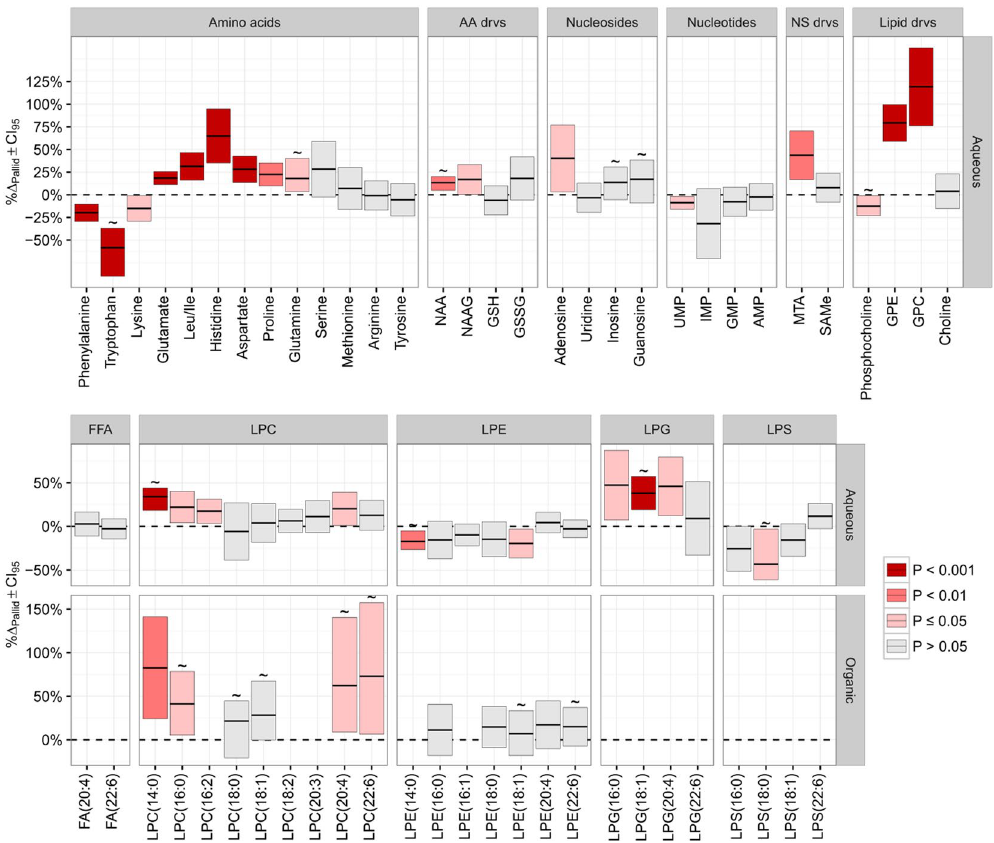
Figure 3. Percentage change for metabolite levels in hippocampi of pallid mice (% Δ Pallid ± 95% confidence intervals) with respect to wild-type (WT) animals. The following formula was used: % Δ Pallid = 100% * ([Pallid] − [WT])/[WT]. Either the mean or the median (indicated by ~) values of corrected signals are used, depending on the statistical test. Confidence intervals and P values were obtained via two sample t-tests (Student’s or Welch) except for metabolites indicated with a ~ for which the statistics were calculated with the Wilcoxon rank sum test. Significance levels are color-coded using shades of red. AA, amino acids; drvs, derivatives; NS, nucleosides; FFA, free fatty acid; LPA, lysophosphatidic acid; NAA, N-acetyl-aspartate; NAAG, N-acetyl-aspartyl-glutamate; GSH, glutathione (reduced); GSSG, (oxidized); UMP, uridine monophosphate; IMP, inosine monophosphate; GMP, guanosine monophosphate; AMP, adenosine monophosphate; MTA, methylthioadenosine; SAMe, S-adenosyl-L-methionine; GPE, glycerophosphoethanolamine; GPC, glycerophosphocholine. Lipid nomenclature: H(c:b), H signifies the head group, c is the number of carbons in the acyl chain and b is the number of unsaturated bonds in the acyl chain; FA, fatty acid; LPC, lysophosphatidylcholine; LPE, lysophosphatidylethanolamine; LPG, lysophosphatidylglycerol; LPS, lysophosphatidylserine. Boxplots for the observed metabolites can be found in the Supplemental 1 and Figs